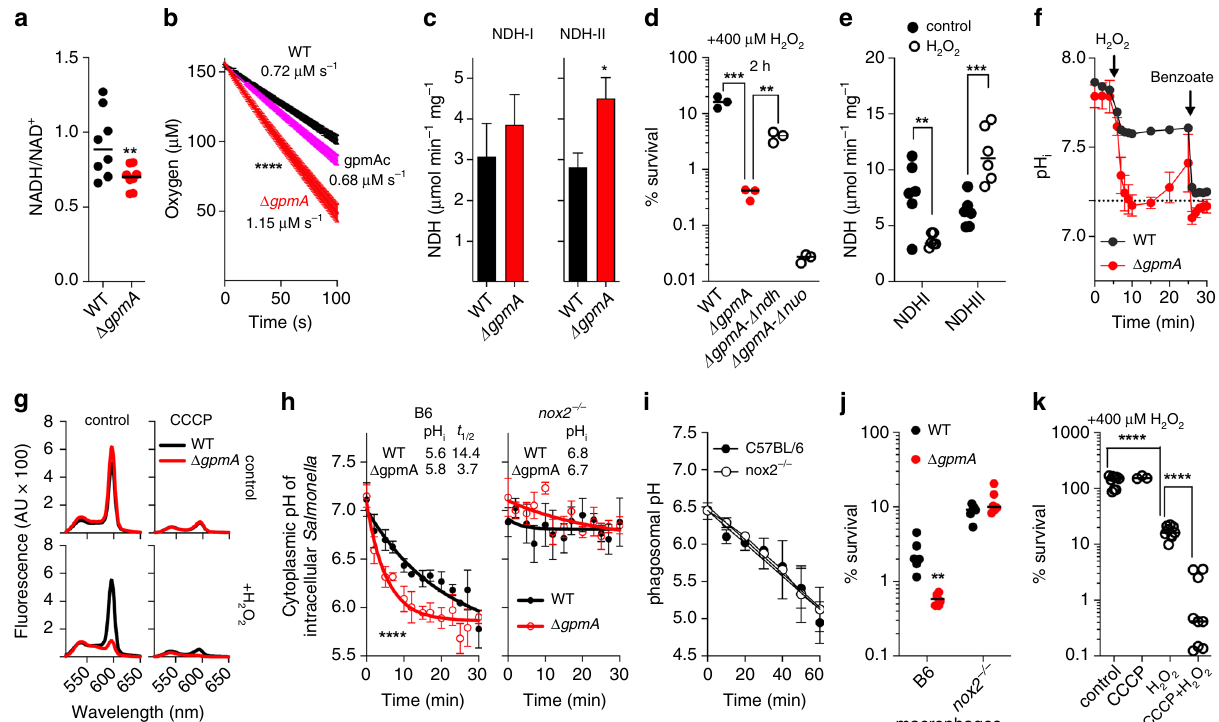
Fig. 3 Glycolysis preserves Δ pH and mediates antioxidant defense. a NAD + and NADH in log phase wild-type (WT) or Δ gpmA Salmonella grown in aerobic MOPS-glucose media. Mean ± SD; N = 8. b Aerobic respiration of log phase Salmonella grown in MOPS-glucose media was measured by polarography. Mean ± SEM; N = 6 except 4 for the complemented strain. c NADH-I and II dehydrogenase enzymatic activities of log phase Salmonella in